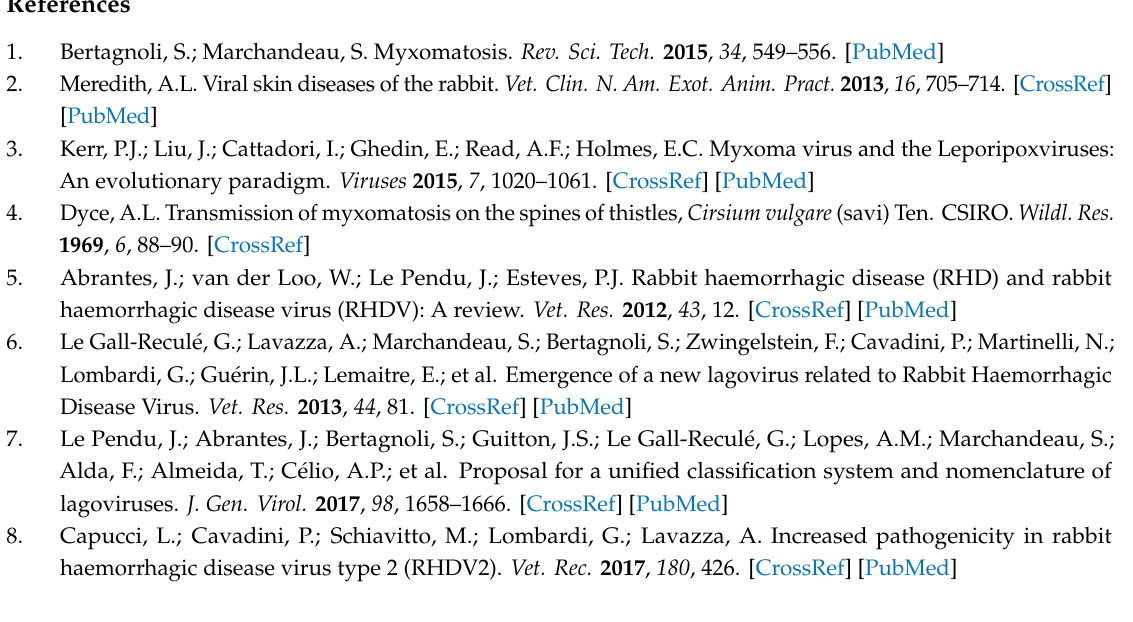
Table S1A: Observed clinical and local reactions in study 1 (specific pathogen free (SPF) rabbits), Table S1B: Table S2B: Macroscopic analysis injection sites in study 1 (SPF rabbits), Table S2C: Macroscopic analysis injection sites in study 2 (DB rabbits), Table S3A: Histological analysis of the injection sites in study 1 (SPF rabbits), Table S3B: Histological analysis of the injection sites in study 2 (DB rabbits), Table S4: Summary of antibody titres to RHDV1, RHDV2 and myxoma virus (S4A NZW rabbits, S4B DB